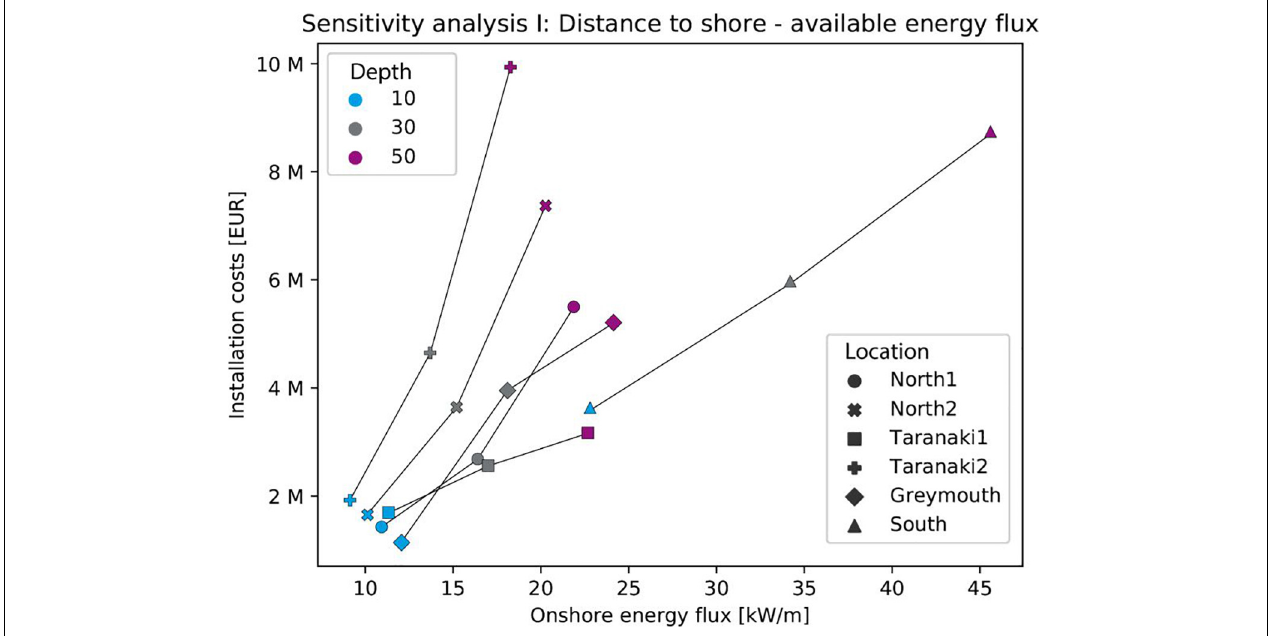
FIGURE 3 | Relative installation costs [EUR] for cables (submarine and onshore) and deployment with vessel, depending on measured distances from six chosen locations. Available onshore energy flux in 30 m depth taken from WAM (Gorman et al., 2003) linear assumption for onshore energy flux at 10 and 50 m deep sites. Lines connect three depths of each location. A less steeper gradient implies a more favourable onshore energy flux—installation costs ratio. TABLE 4 | The displayed EUR/kW values depend on energy flux (10, 30, 60 kW/m), number of devices (10-100-500) and chosen design (longline or raft). (a) Energy flux: 10 kW/m Energy flux: 30 kW/m Energy flux: 60 kW/m Design Design Design